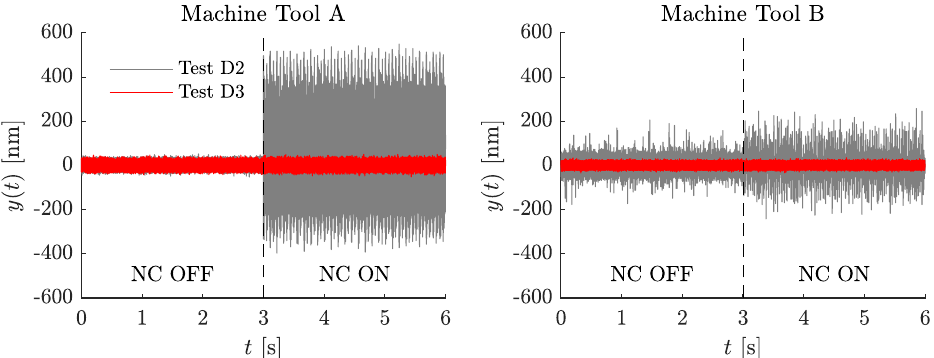
Figure 13. Output signal y ( t ) for Configurations D2 (target coupled to spindle) and D3 (decoupled spindle measurement setup) in different machine tool environments and operating modes.